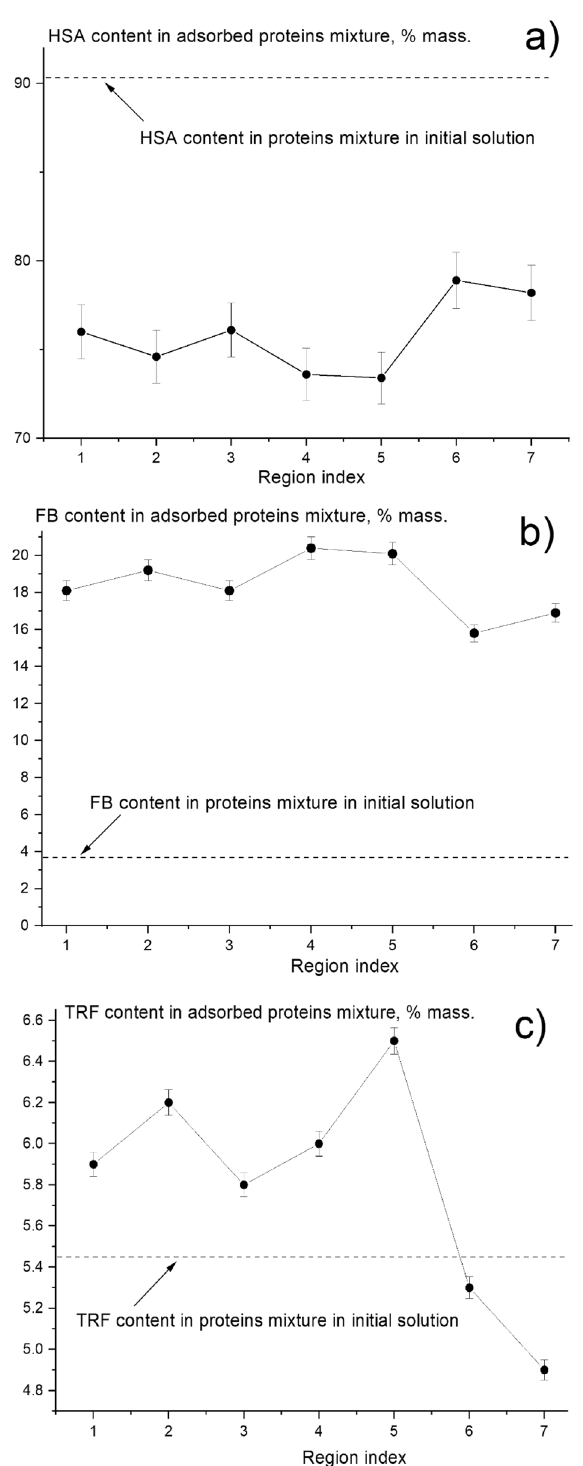
Figure 5. Protein content in the adsorbed protein mixture in each membrane region index: ( a ) HSA; ( b ) FB; ( c )